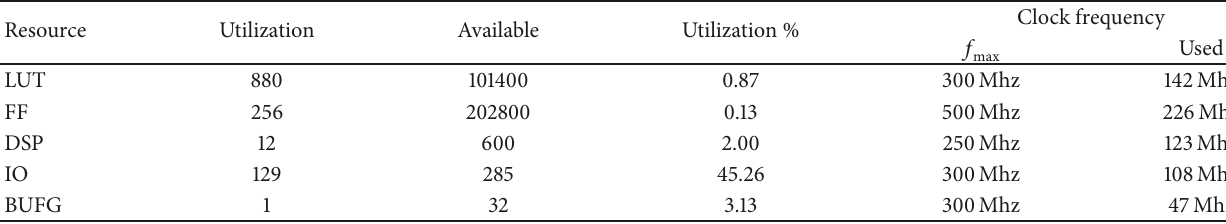
Table 7: Resource utilization of FONCS-3